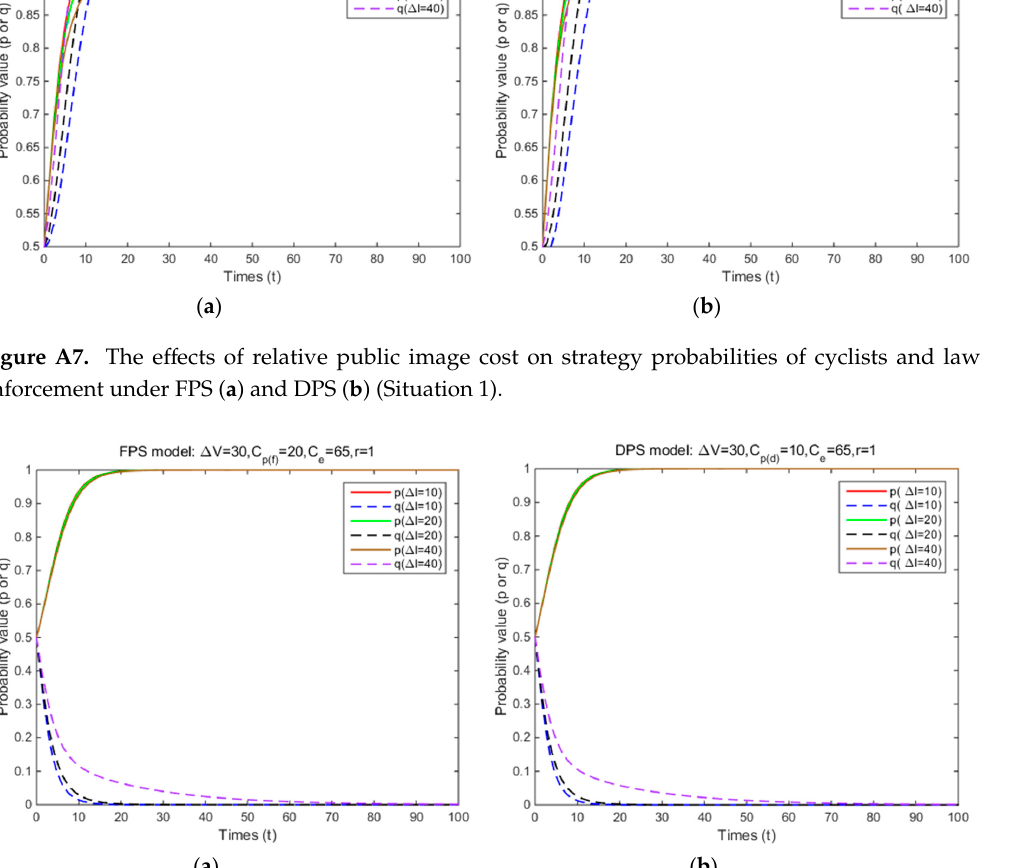
Figure A8. The effects of relative public image cost on strategy probabilities of cyclists and law enforcement under FPS ( a ) and DPS ( b ) (Situation 2).